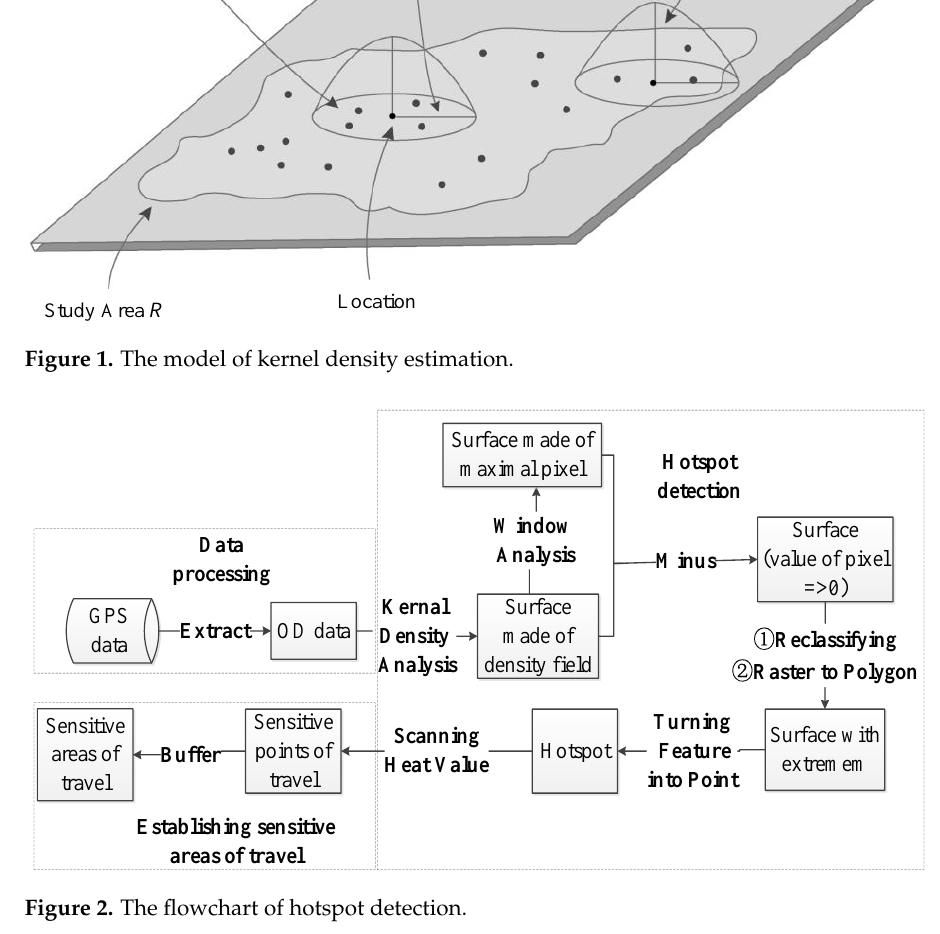
Figure 1. The model of kernel density estimation. Figure 2 exhibits the algorithm flow of hotspot detection according to density field.